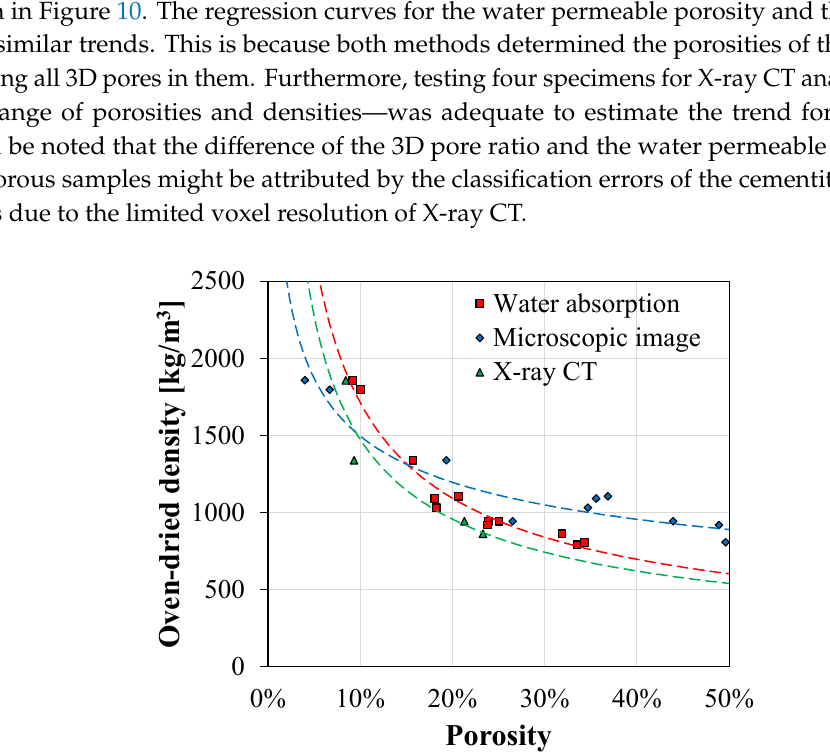
Figure 10. The relationship of the oven-dried density with the porosities obtained using the water absorption test, microscopic image processing, and X-ray CT analysis.